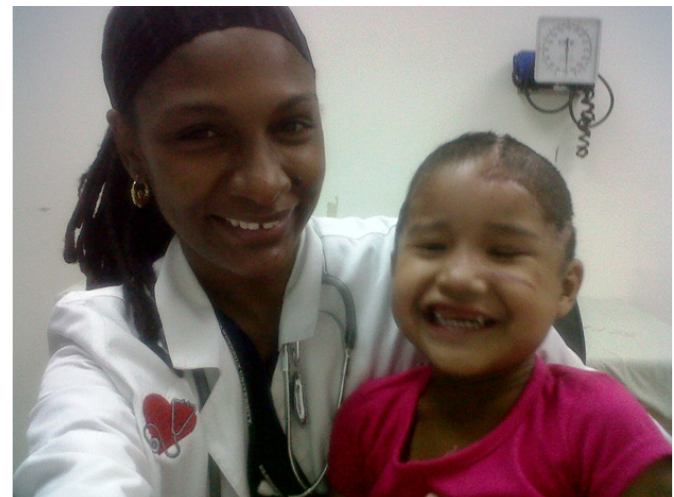
Figure 5. Child in the clinic prior to discharge (published with written parental permission).